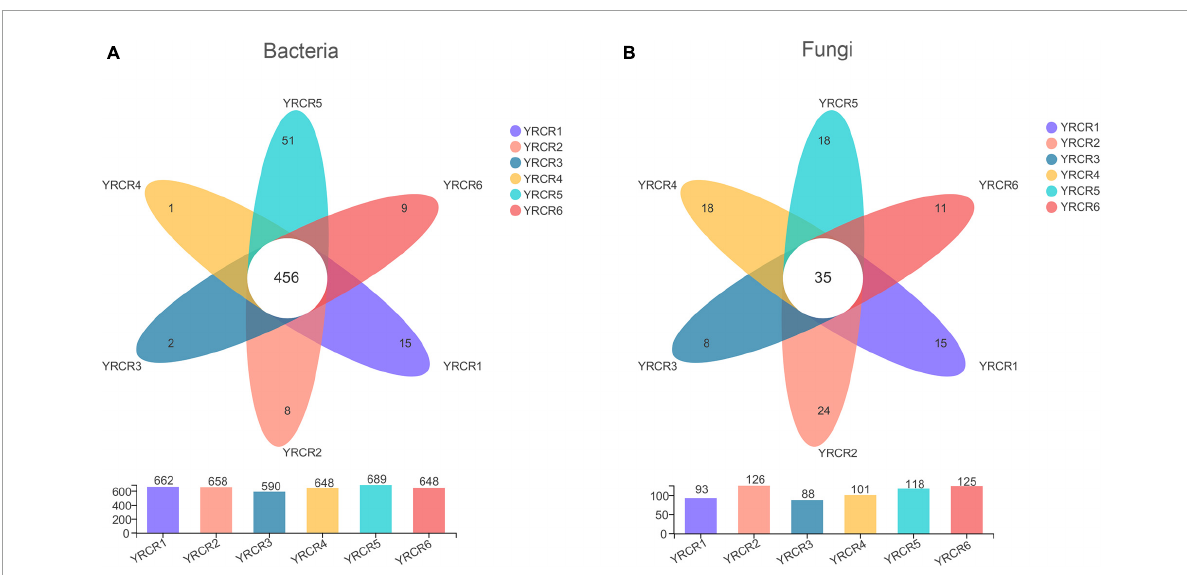
Jiao et al. (2021) and Wang et al. (2021) came up to the same result. Jiao et al. (2021) demonstrated that the balance between positive and negative bacterial-fungal associations was connected to the link between soil biodiversity and